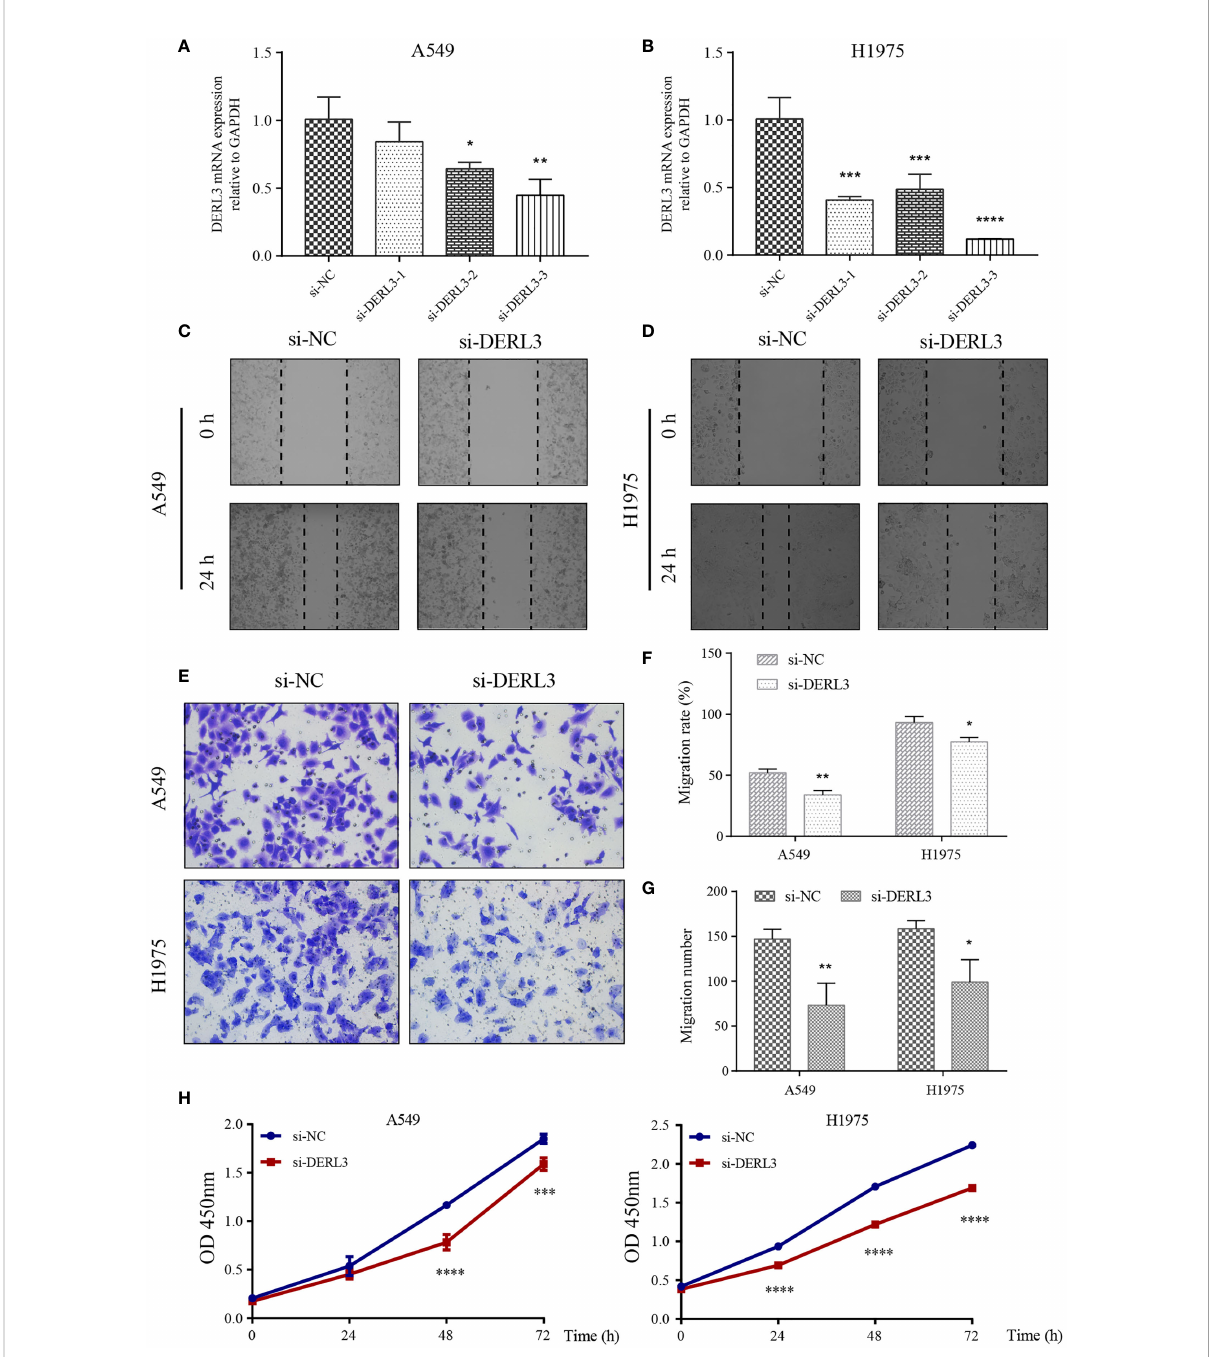
FIGURE 7 Knockdown of DERL3 inhibited cell migration and proliferation. (A, B) Silencing ef fi ciency was identi fi ed in A549 and H1975 cells after siRNA transfection. (C, D) Scratch assays of A549 and H1975 cells after transfection with si-DERL3. (E) Transwell migration assays were performed after transfection with si-DERL3 in A549 and H1975 cells. (F, G) Statistical analysis of transwell migration assays and scratch assays were presented. (H) CCK-8 assay was performed to evaluate the proliferation of A549 and H1975 cells after silencing DERL3. (*p < 0.05, **p < 0.01, ***p < 0.001, ****p <